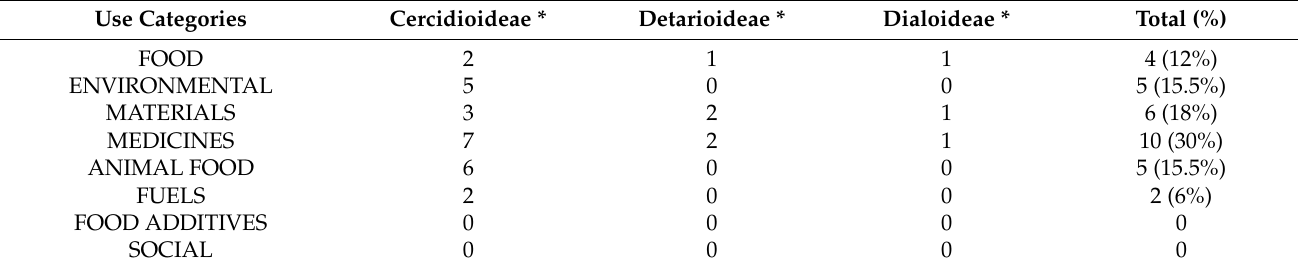
Table 2. Values of use categories and total percent of Cercidioideae (7 spp.), Detarioideae (3 spp.), Dialoideae (1 sp.), excluding Caesalpinioideae and Papilionoideae. Categories values are based on Figure S1 (Supplementary Materials). * 100% woody